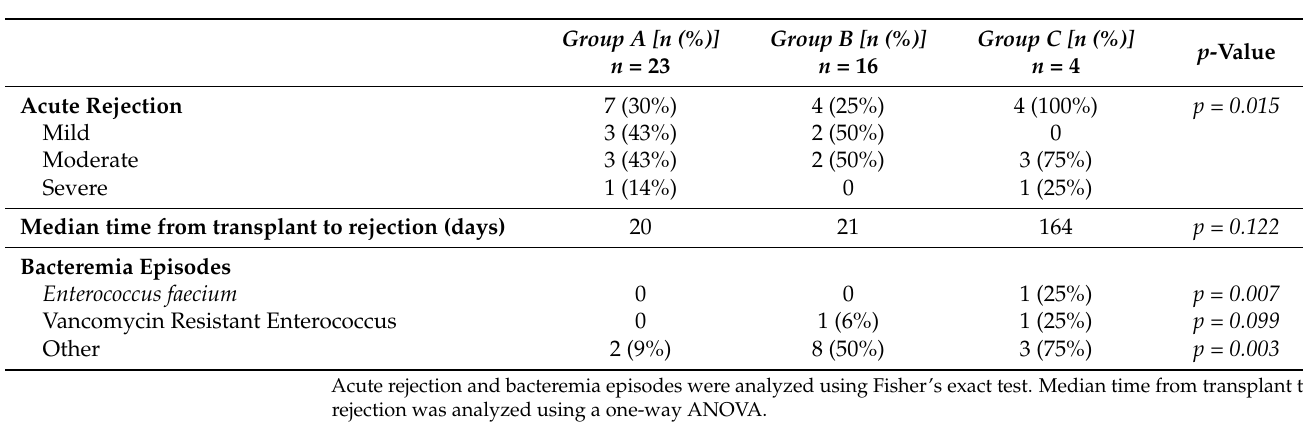
Table 2. Rejection and Infection.